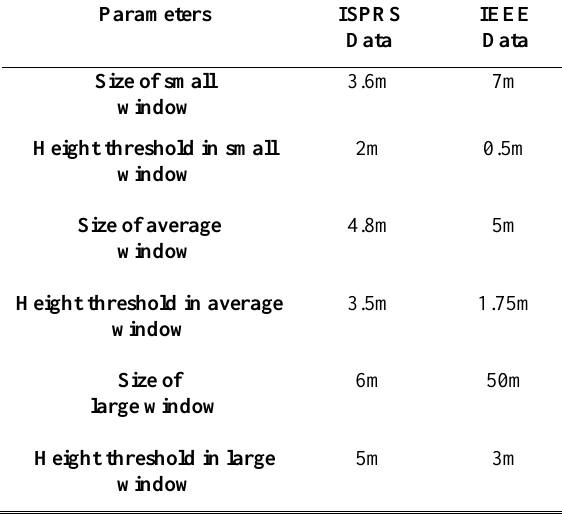
Table1. Parameter values for filtering raw LiDAR data.